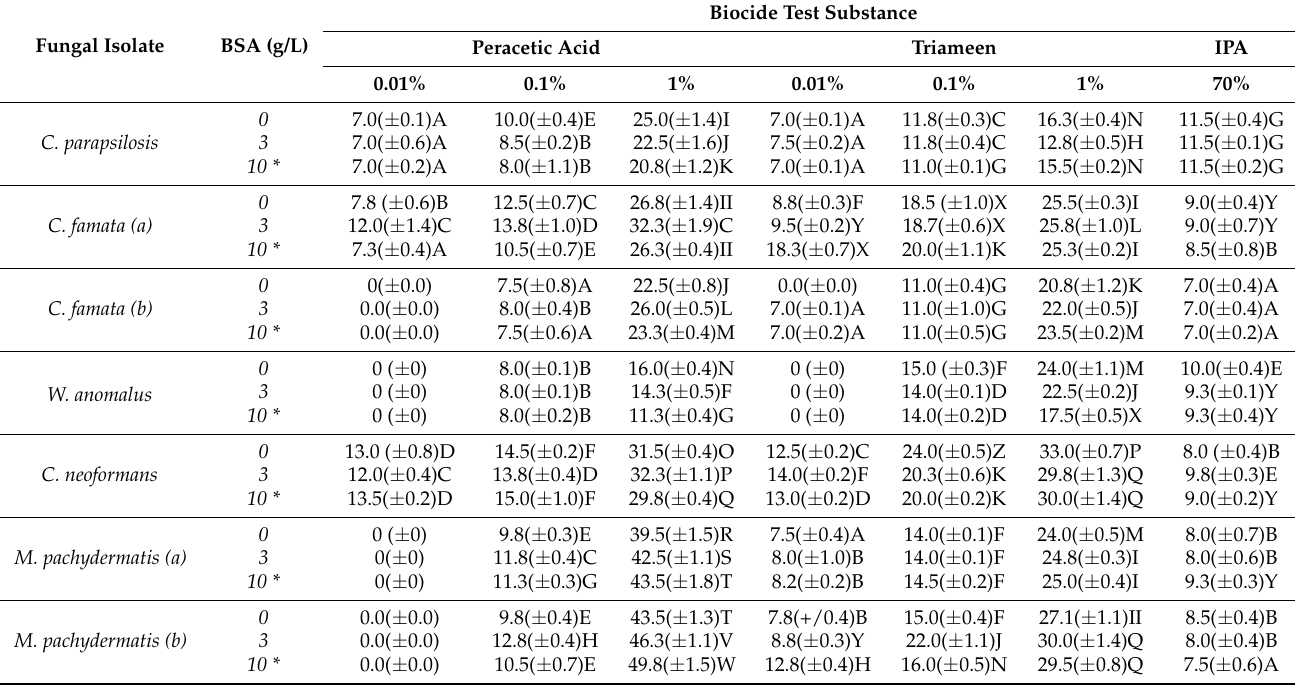
Table 4. Zones of inhibition (mm) produced by antimicrobial biocides against fungal isolates in the absence and presence of interfering substance BSA at 3 and 10 g/L (+10 g/L YE) ( ± standard deviation).